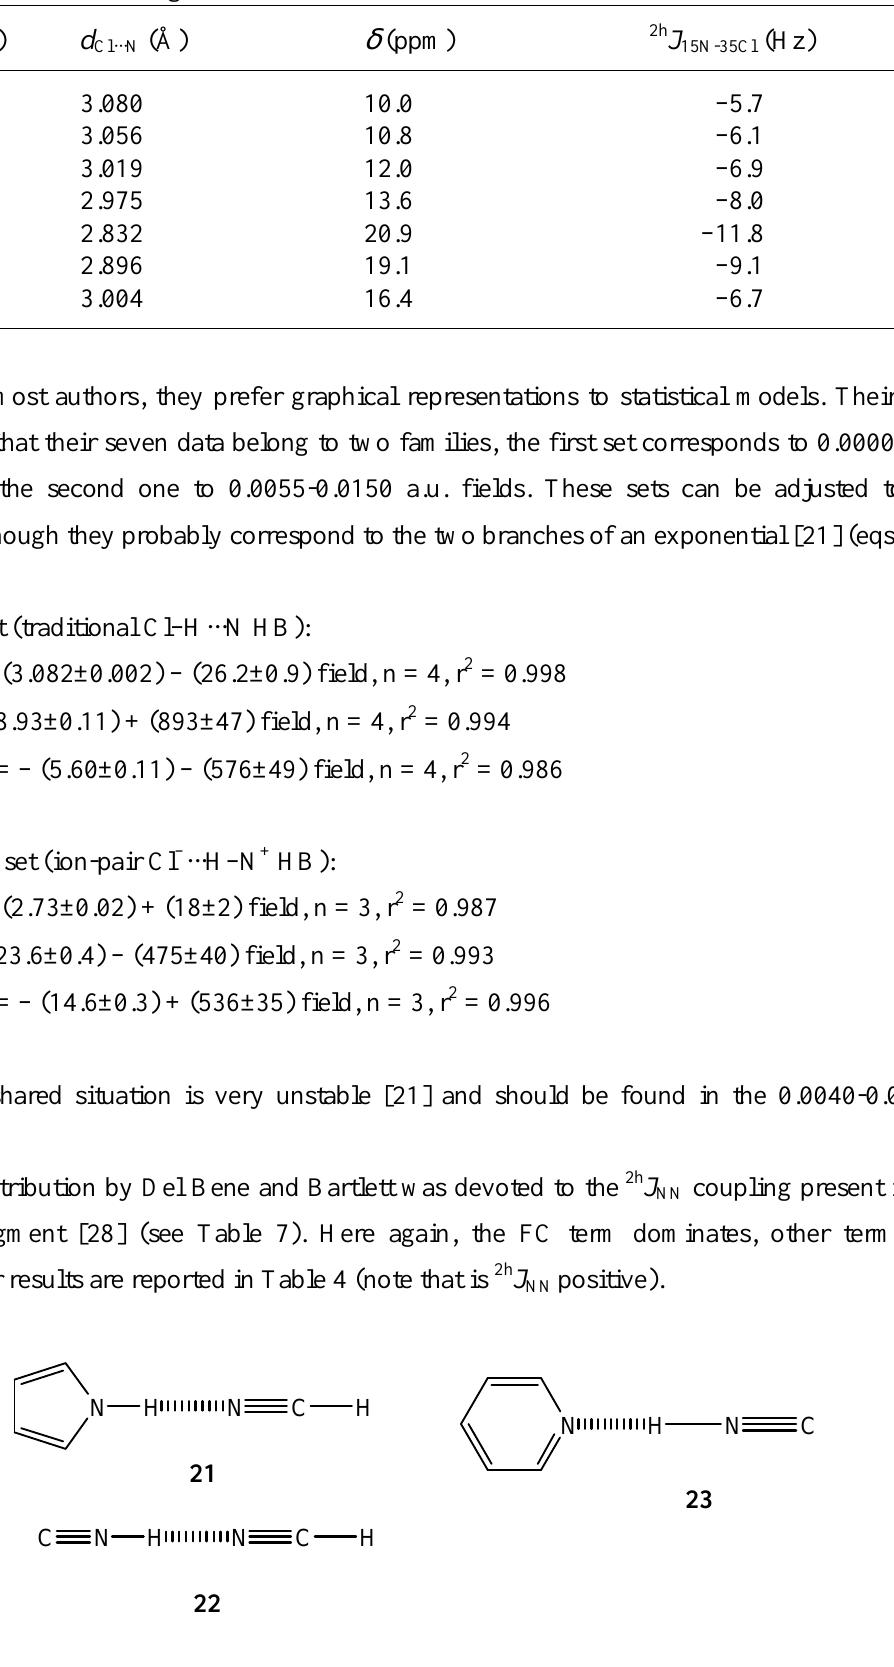
coupling constants as 15N-35Cl